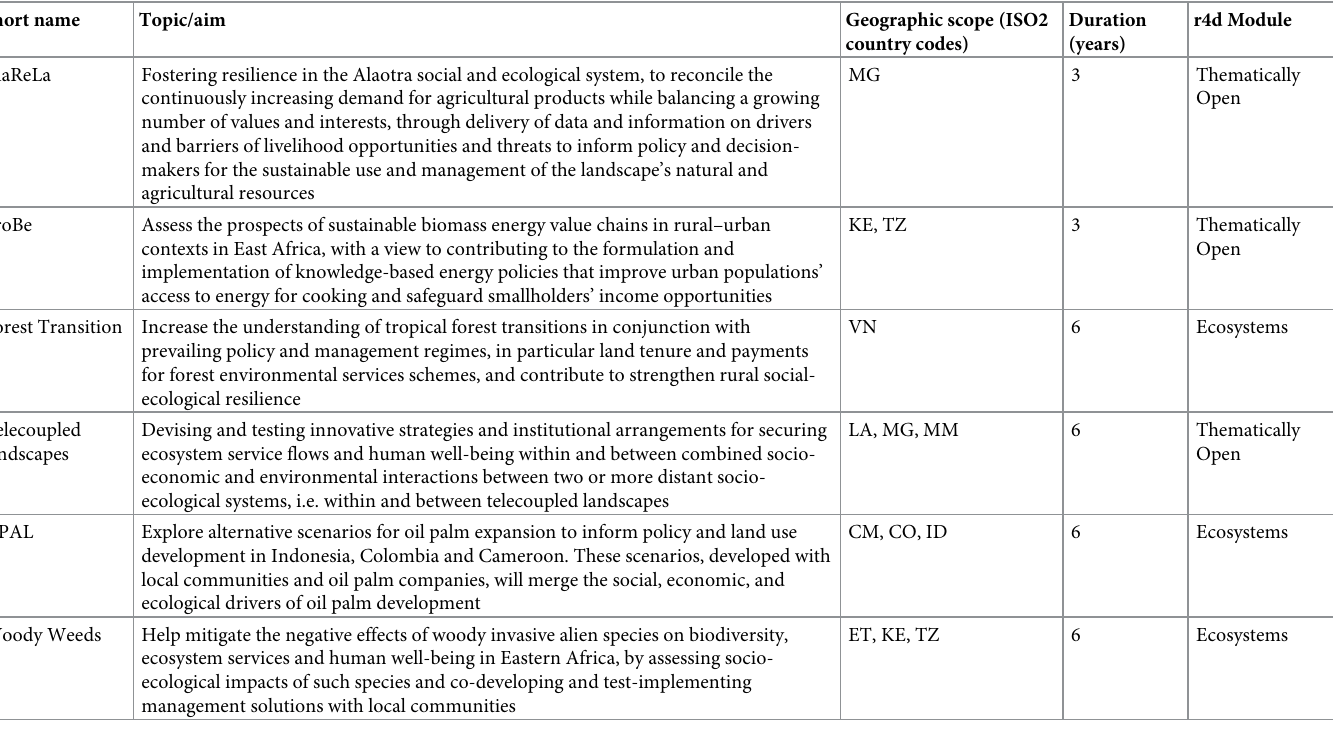
Table 2. Short descriptions of the studied projects. Two projects for which no responses were obtained are not listed. More information can be found on